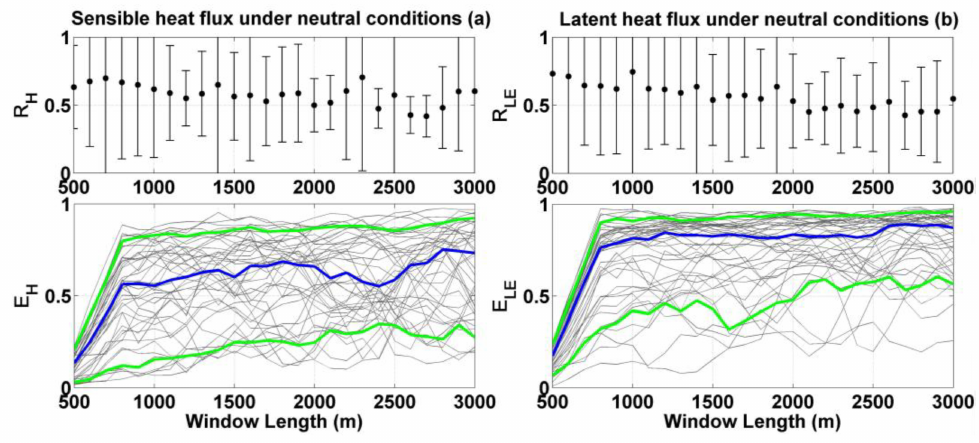
Figure 7. Averaged relative flux uncertainties (R H , R LE ) with standard deviation ( top panels) and block ensemble averaged non-dimensional flux (E H , E LE ) ( bottom panels) for sensible heat flux ( a ) and latent heat flux ( b ) under neutral conditions. In the bottom panel, the solid blue curves represent the median value, while the solid green lines depict the 10th (lower) and 90th (upper)